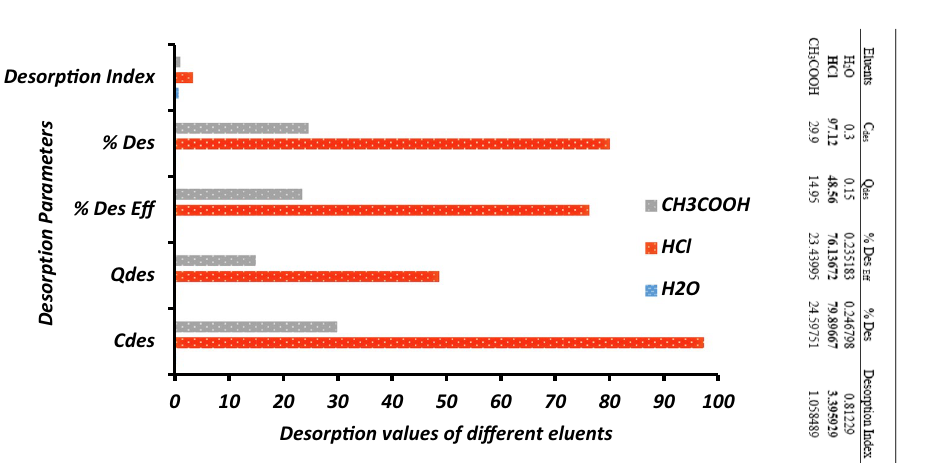
Figure 4. Comparative effect of different eluents in the desorption of Cu 2+ from Cu 2+ -loaded